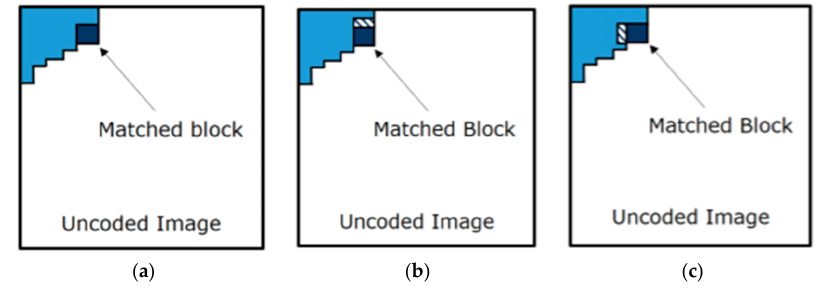
Figure 4. An example of the OneRow+OneColumn Dictionary Update Heuristic. ( a ) The matched